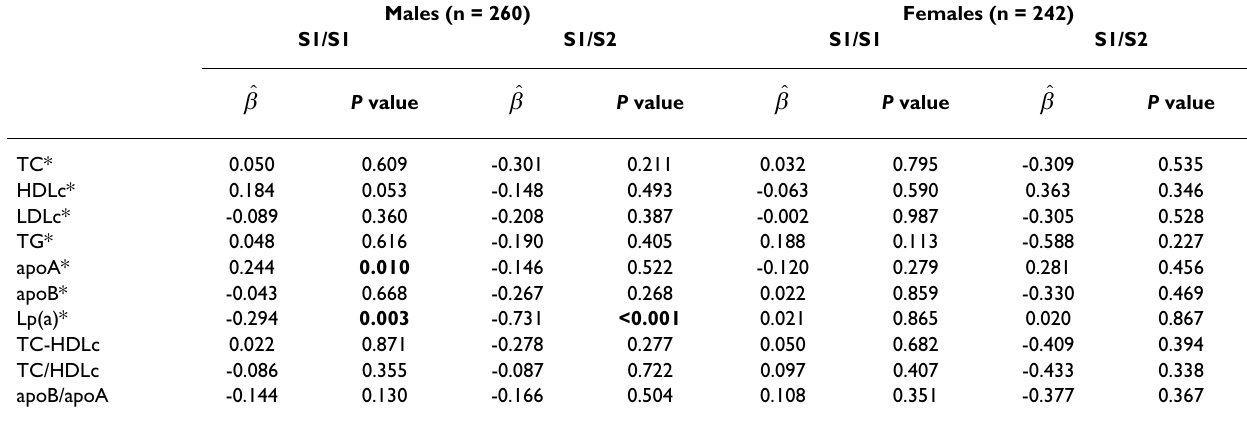
Table 6: Regression coefficients ( ) showing the association between birth weight score and lipid and lipoprotein levels by APOC3 genotypes and sex after controlling for age, pubertal stage, socioeconomic status, gestational age, body mass index and cardiorespiratory